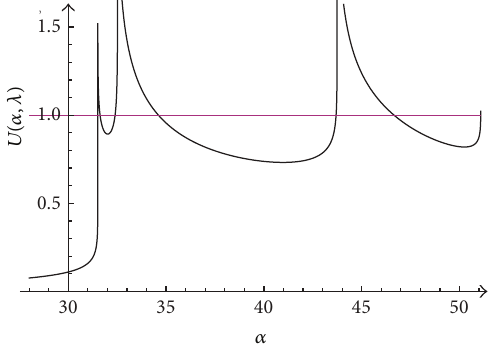
Figure 14: Five solutions of problem (15), (10), 𝛼 ≈ 26.4119 , 𝛼 ≈ 30.6763 , 𝛼 ≈ 36.3664 , 𝛼 ≈ 40.8286 , and 𝛼 ≈ 42.7074 .